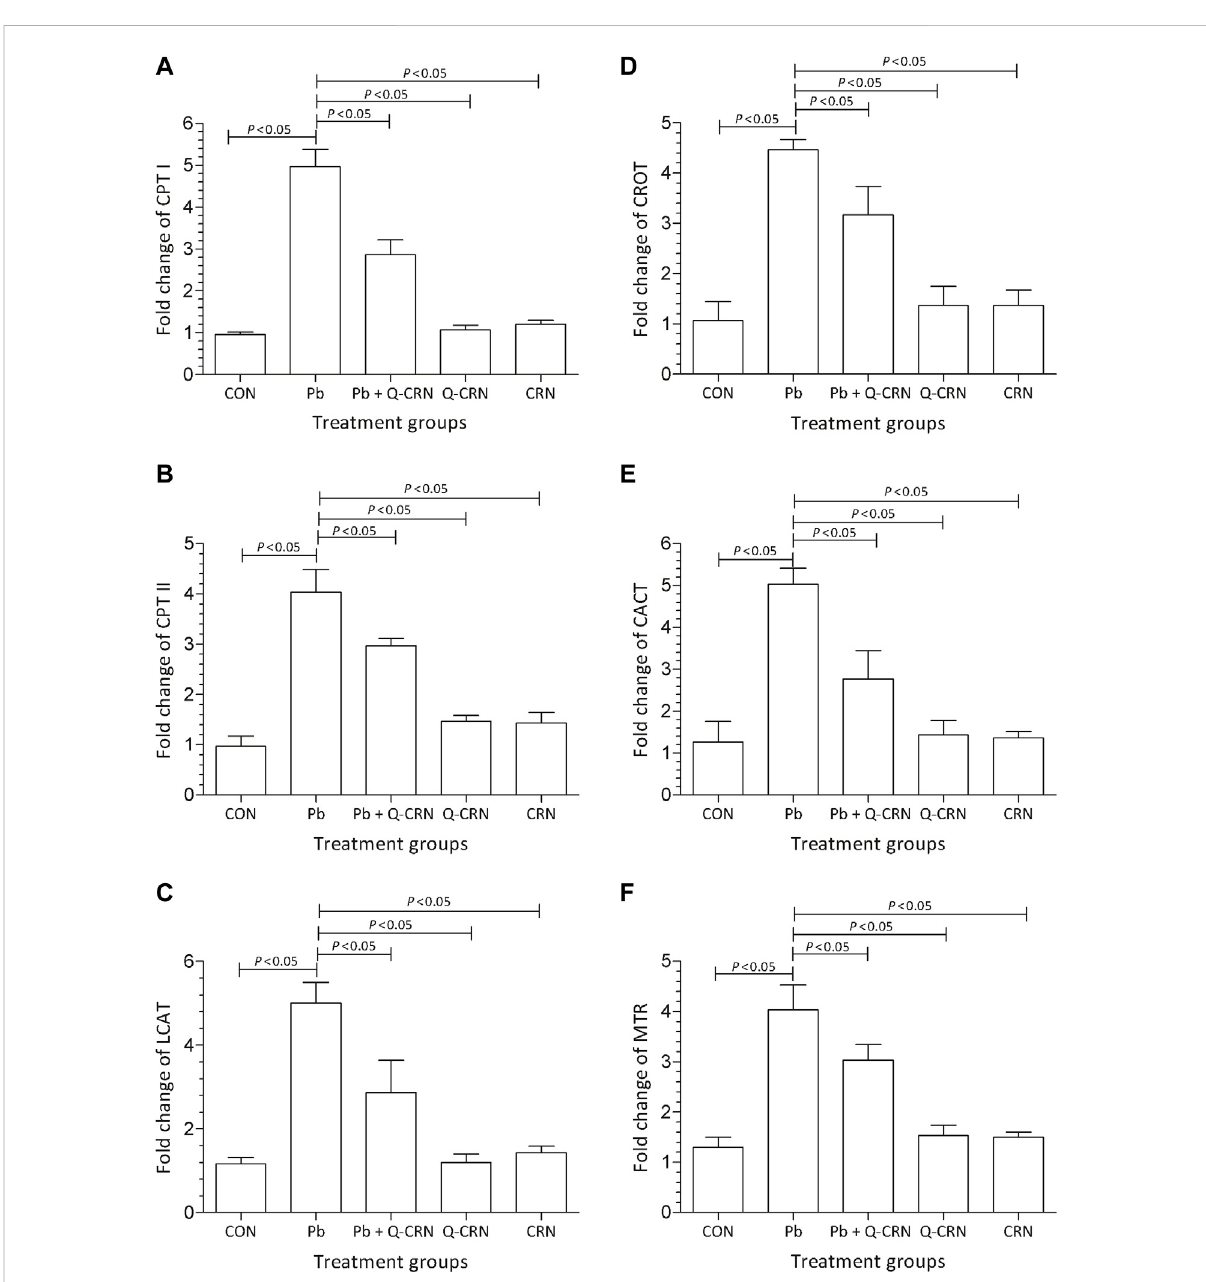
FIGURE 4 Bar diagram represents the effect of PbAc on mRNA expression of the (A) CPT I, (B) CPT II, (C) LCAT, (D) CROT, I CACT, and (F) MTR genes in different mice groups, i.e., CON, Pb, Pb + Q-CRN, Q-CRN, and CRN groups, respectively. The quantitative analysis was carried out at the end of the experimentof28 days.Thesigni fi cancelevelwassetat( p < 0.05)byusingone-wayANOVAfollowedbyTukey ’ stesttocompareallpairsofcolumns. Each error bar represents the mean ± SD. Abbreviations: CPT I carnitine palmitoyltransferase I; CPT II: carnitine palmitoyltransferase II; LCAT: lecithin – cholesterol acyltransferase; CROT: carnitine O-octanoyltransferase; CACT: mitochondrial carnitine/acylcarnitine carrier protein; MTR: 5- methyltetrahydrofolate-homocysteinemethyltransferase; CON:control group; Pb: leadgroup; Pb+ Q-CRN: leadand quercetin blendedin corn oil group; Q-CRN: quercetin blended in corn oil group; CRN: corn oil group; ANOVA: analysis of